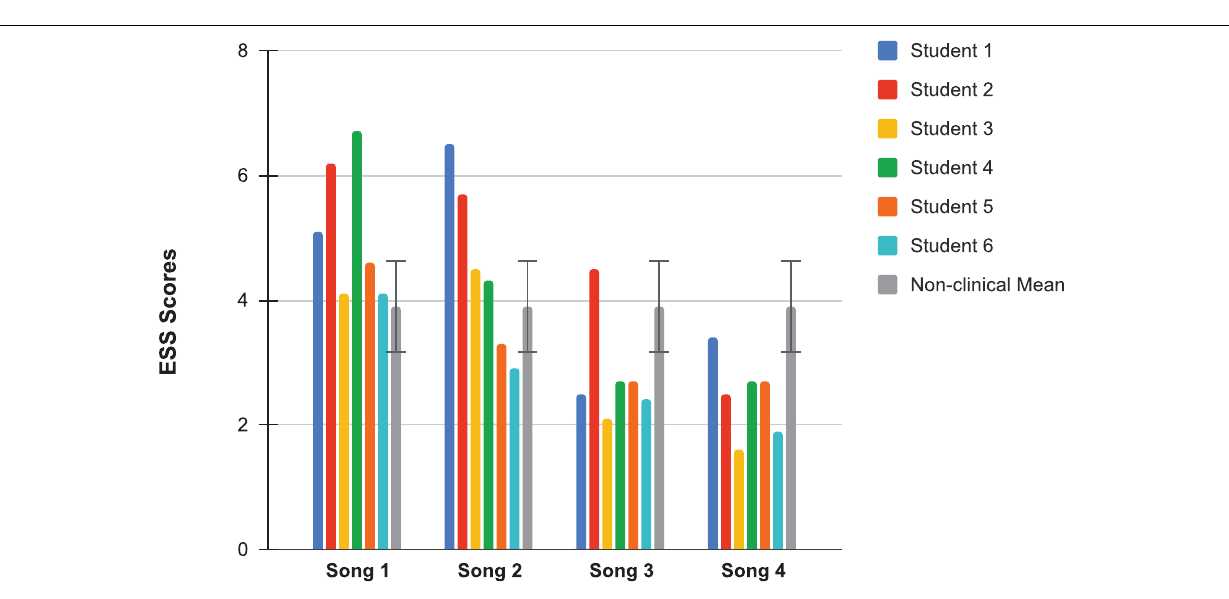
FIGURE 10 | Experiential Shame Scale scores for the current students, from pre-coaching with accompaniment (Song 1), pre-coaching a cappella (Song 2), to post-coaching with accompaniment (Song 3), to post-coaching a cappella (Song 4), with the non-clinical mean (3.9) and bars spanning one standard deviation up/down ( SD = 0.73; Turner,